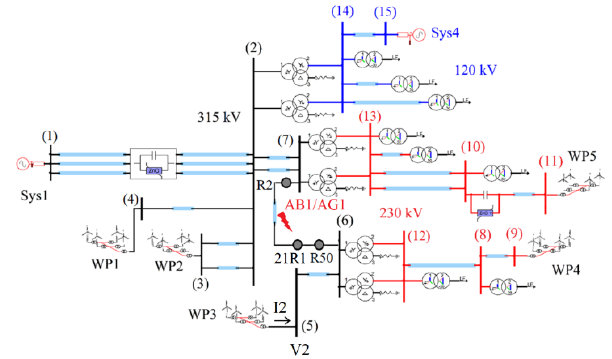
Figure 6. Schematic diagram of the 315/230/120 kV test system.